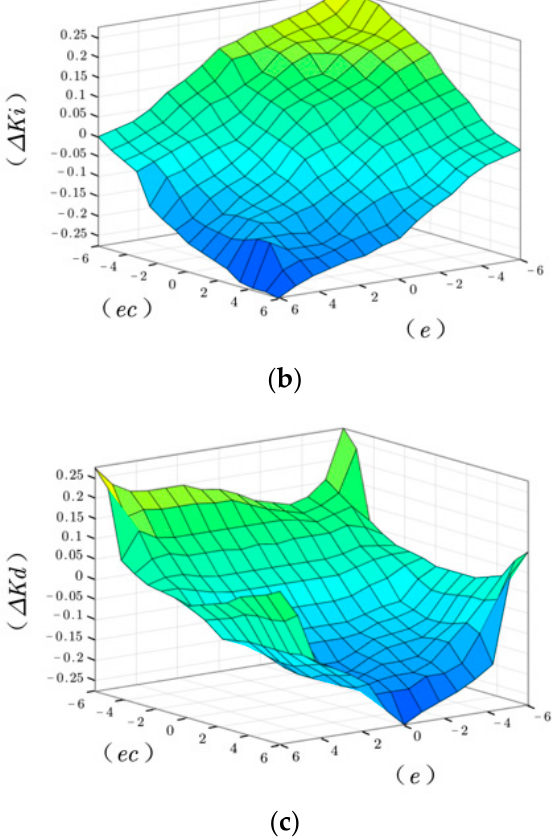
Figure 10. ( a ) The fuzzy inference surface of ∆ K p ; ( b ) the fuzzy inference surface of ∆ K i ; ( c ) the fuzzy inference surface of ∆ K d .